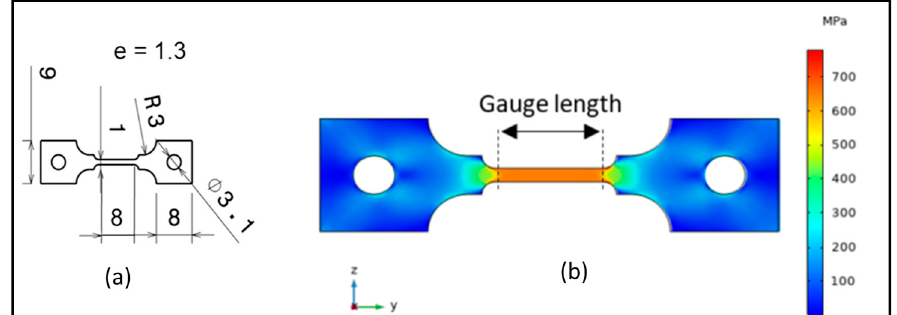
Figure 1. ( a ) Tensile sample geometry and sizes (mm); ( b ) Elastic deformation simulation on COMSOL.